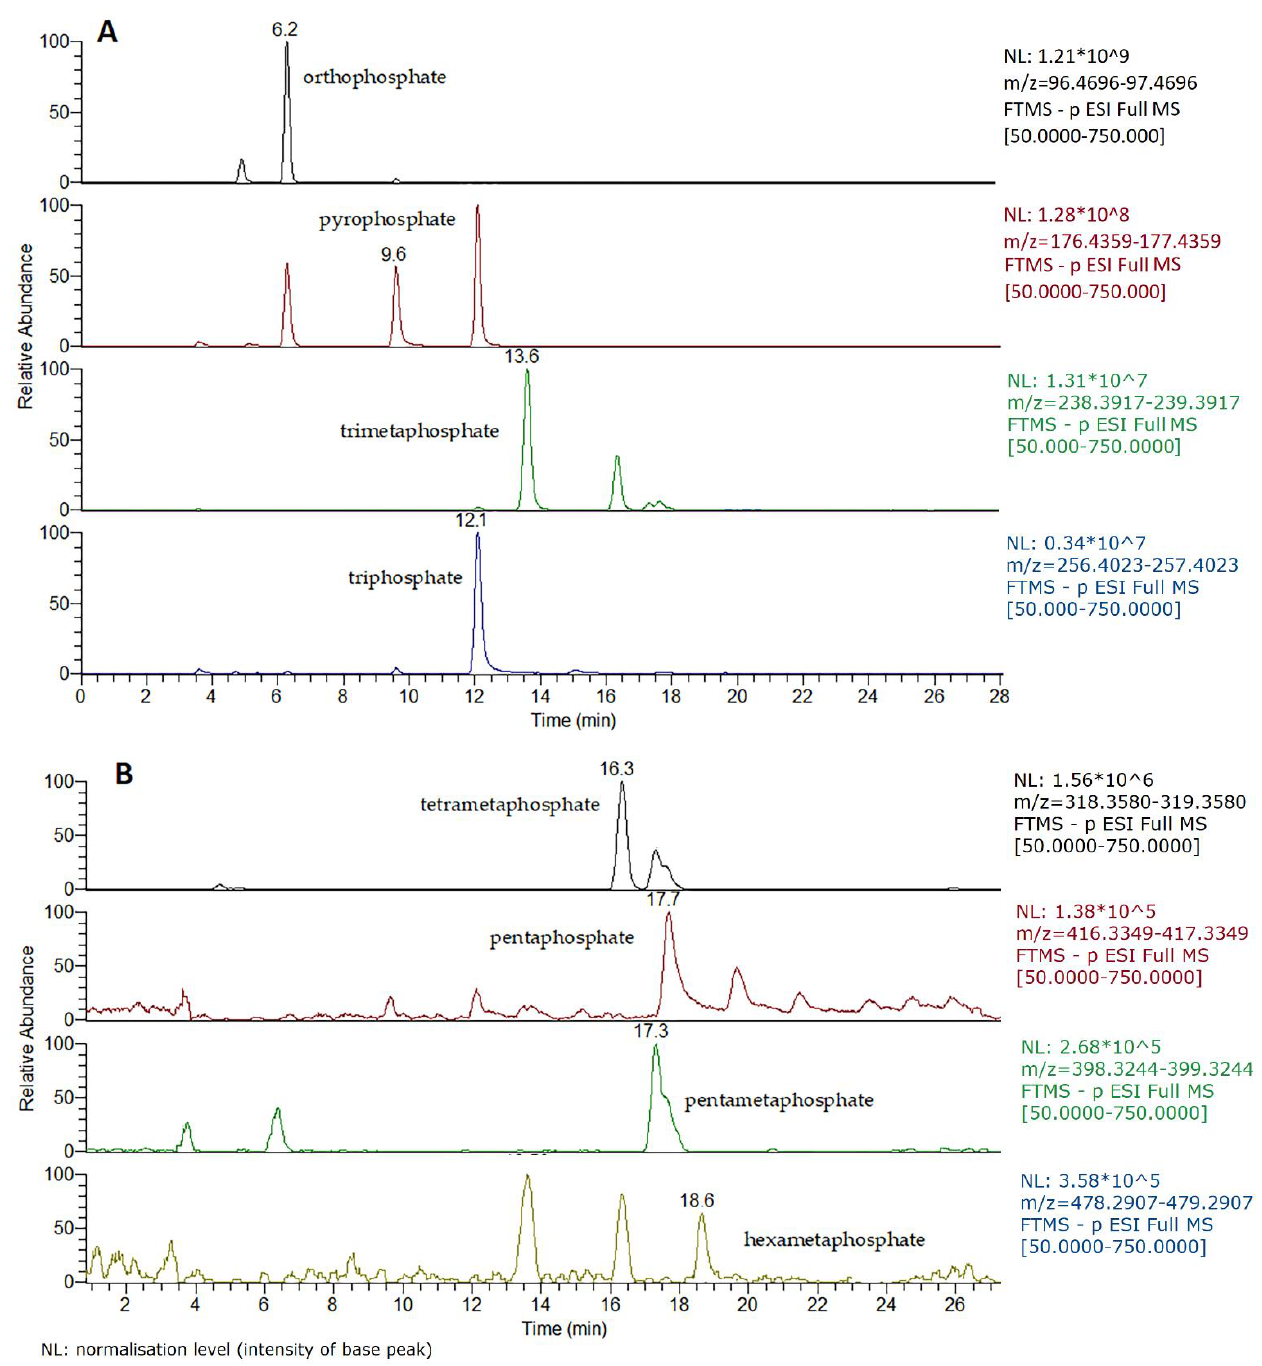
Figure 4. HPIEC – HRMS Q-Exactive Orbitrap ion-extracted chromatogram (TIC) of a cheese sample with declared (poly)phosphate treatment. ( A ) TIC of quantified anions: ortho-, pyro-, trimeta- and triphosphates: 2710, 5626, 6897 and 210 µg/g, respectively. ( B ) Fingerprint of the long-chain polyanions.